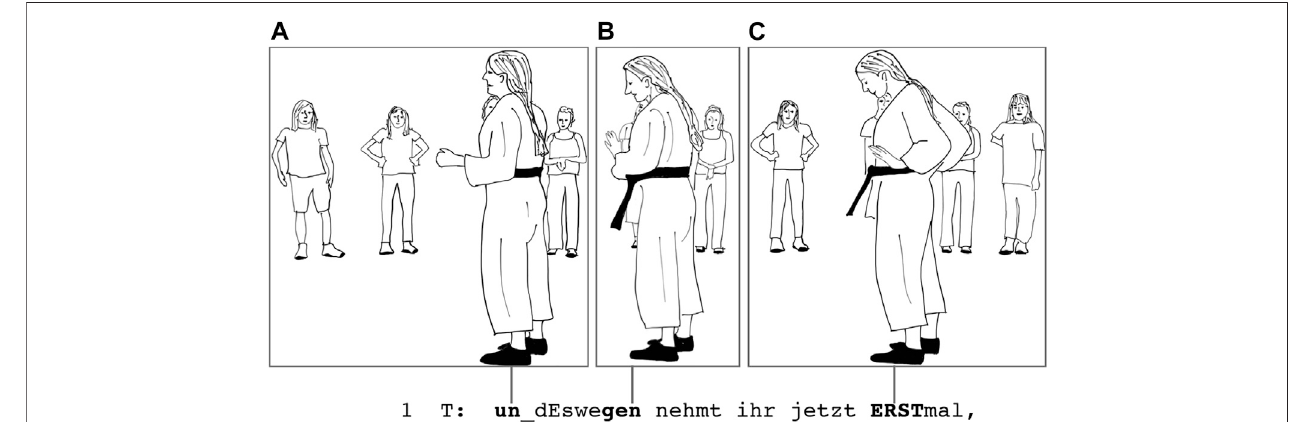
FIGURE 6 | Gaze shift from addressees to hands to index an embodied